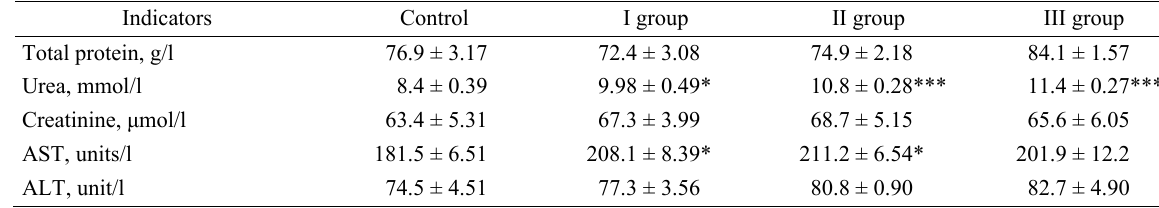
Biochemical indicators of the blood of white rats (M ± m, n = 5)